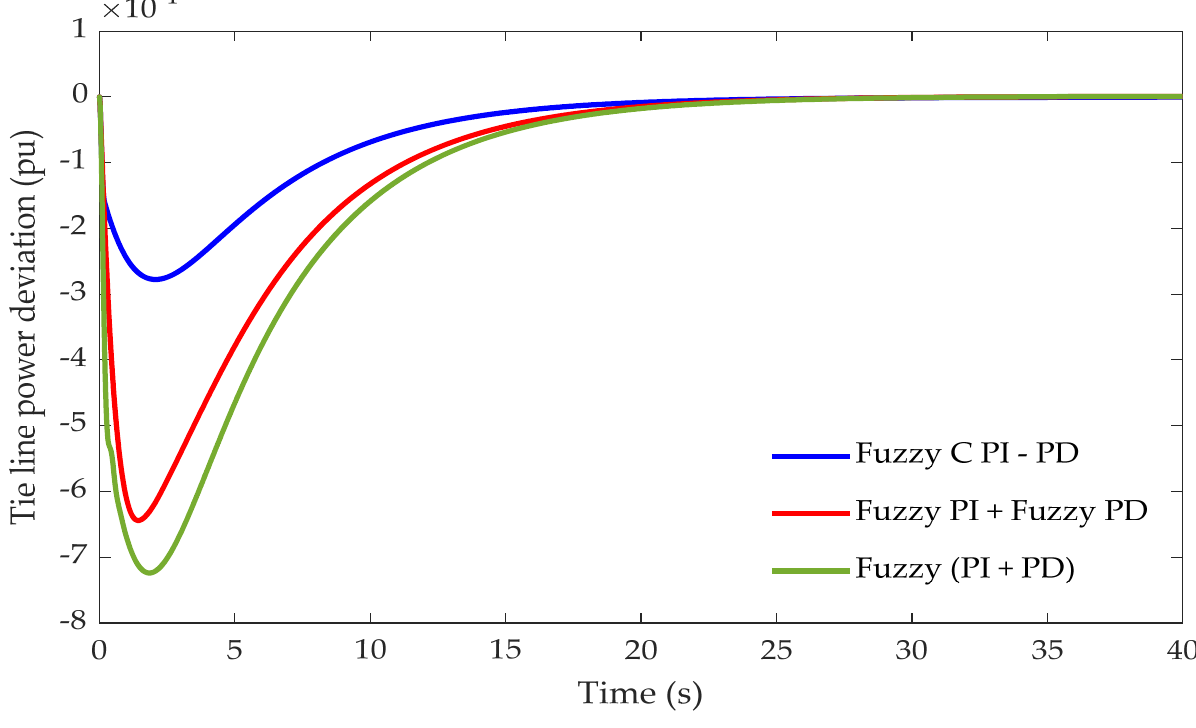
Figure 21. Tie-line power deviation ( ∆ P Table 10. Frequency response performances with different fuzzy control structures tuned by